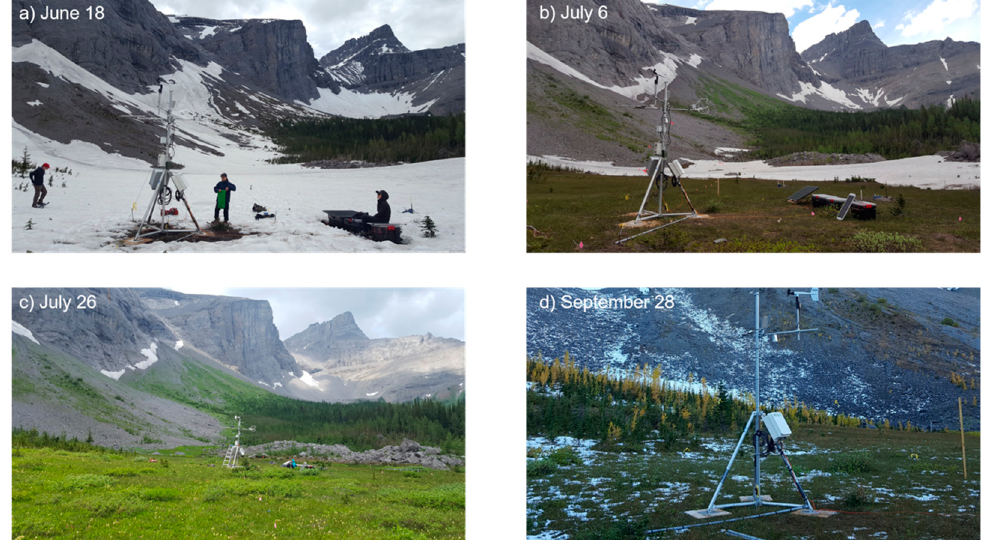
Figure 2. Images of the seasonal evolution of our research site during ( a ) Snow Melt, ( b ) Green-Up, ( c ) Peak Growing Season and ( d ) Late Growing Season. Images were taken during the 2018 field campaign on ( a ) 18 June, ( b ) 6 July, ( c ) 26 July and ( d ) 28 September.